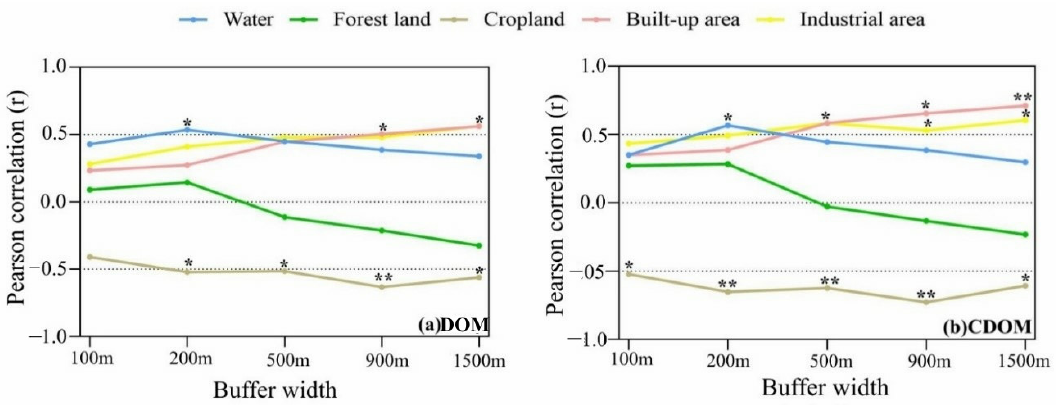
Figure 4. Correlation between DOC, chromophore dissolved organic matter (CDOM) content (a 355 ), and land use types in different riparian buffer scales. * sig. at the level of 0.05; ** sig. at the level of